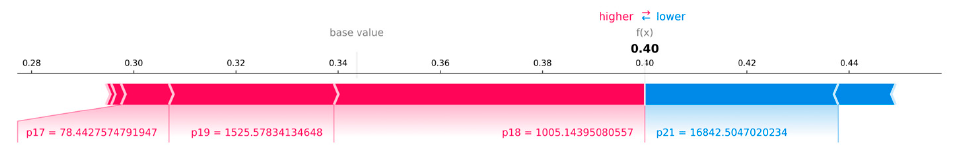
Figure 5. SHAP explanation for a single prediction.